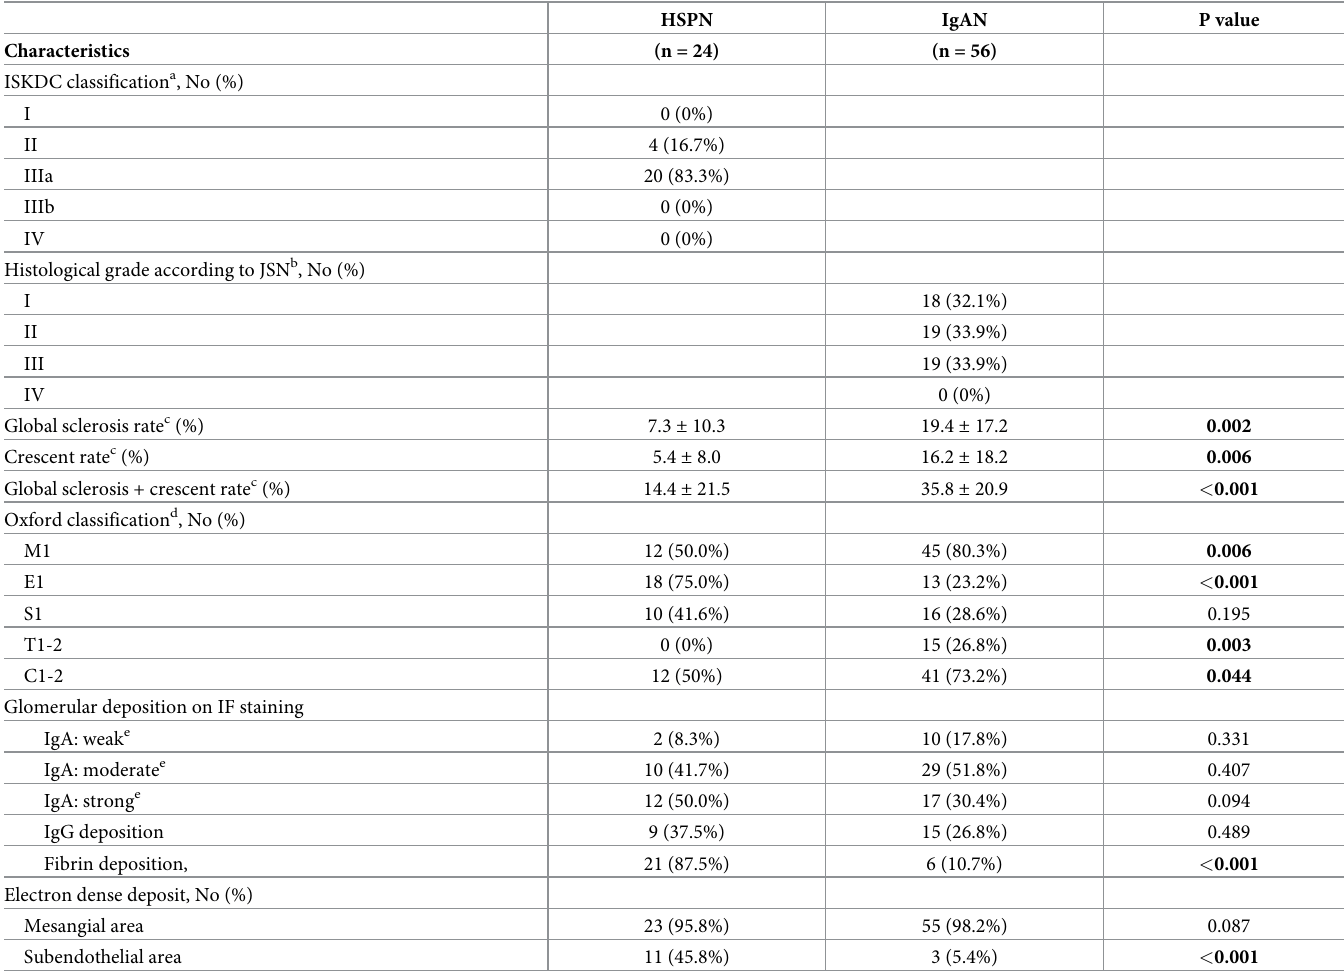
Table 2. Comparison of histologic findings between patients with HSPN and